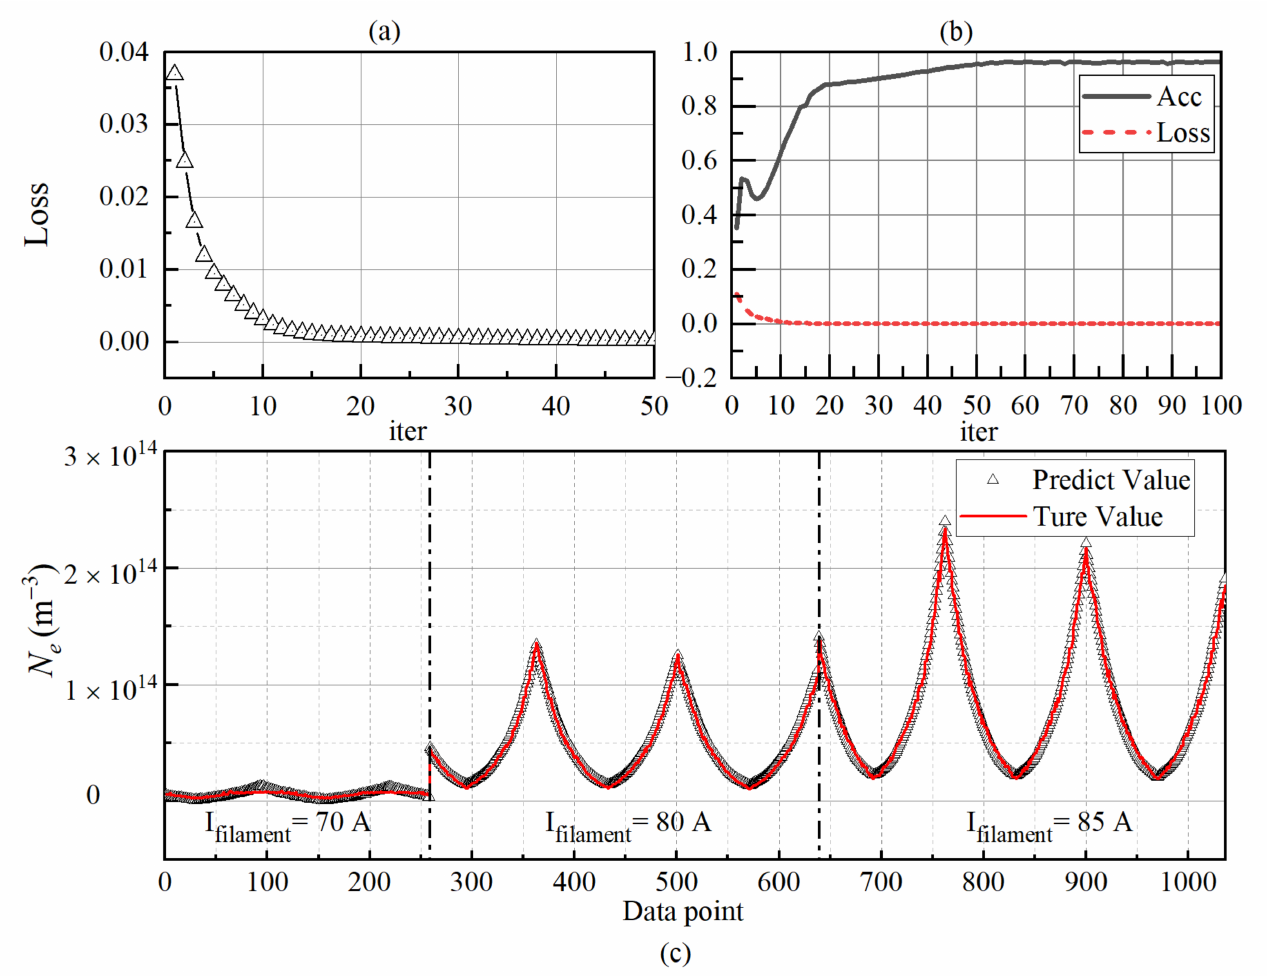
Figure 9. The training and prediction results of the N e . ( a ) The loss rate of the training set data; ( b ) The accuracy and loss of the verification set data; ( c ) Comparison of prediction